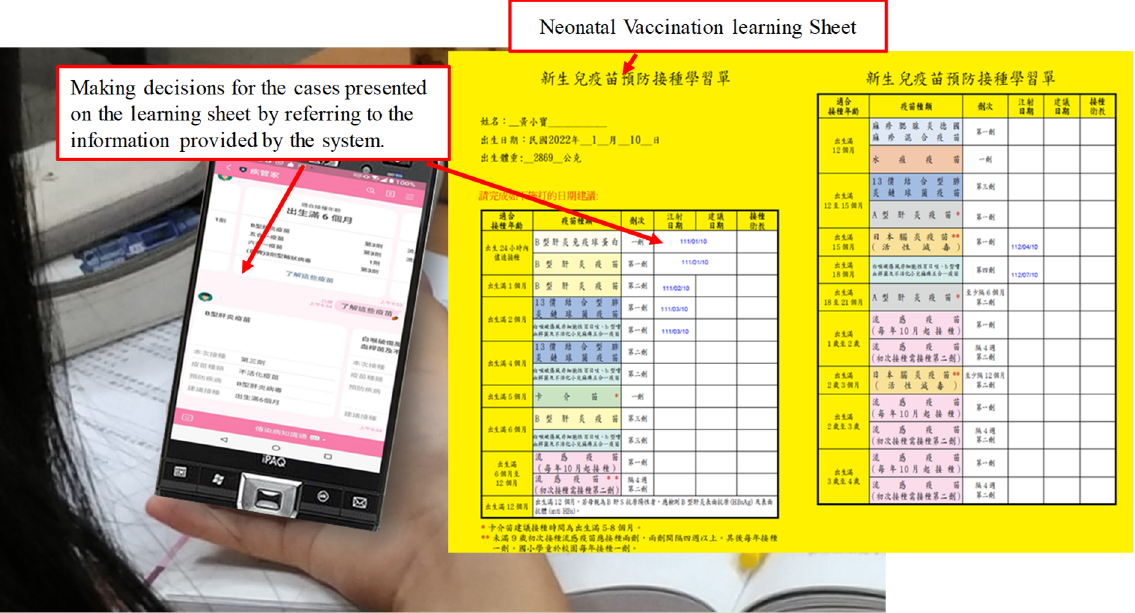
Figure 2. Example of the learning scenario in the Decision stage.